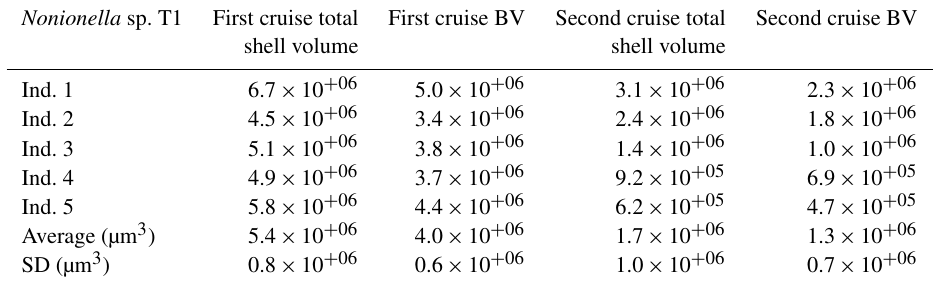
Table 1. Total shell volume (µm 3 ) and the biovolume (BV, µm 3 ) corresponding to 75% of the total shell volume measured on the pool of five Nonionella sp. T1 from the 2017 and the 2018 cruises in the Gullmar Fjord. Abbreviations: Ind. (individual). Nonionella sp.